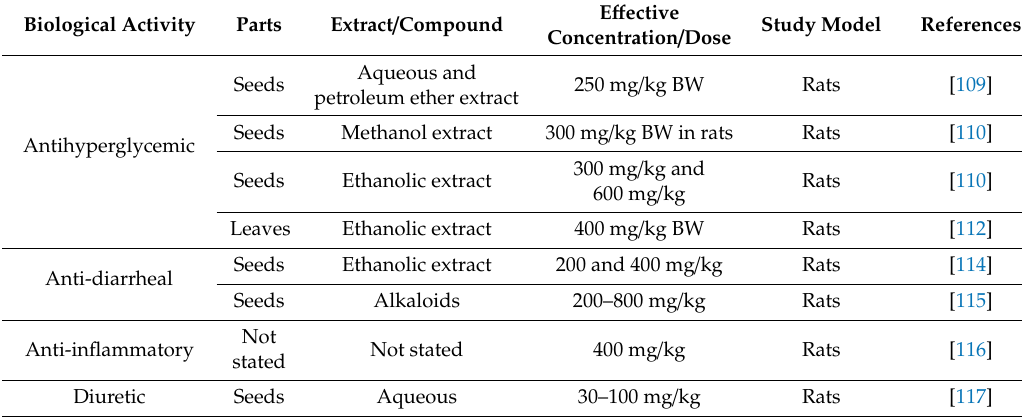
Table 4. In vivo studies with H.